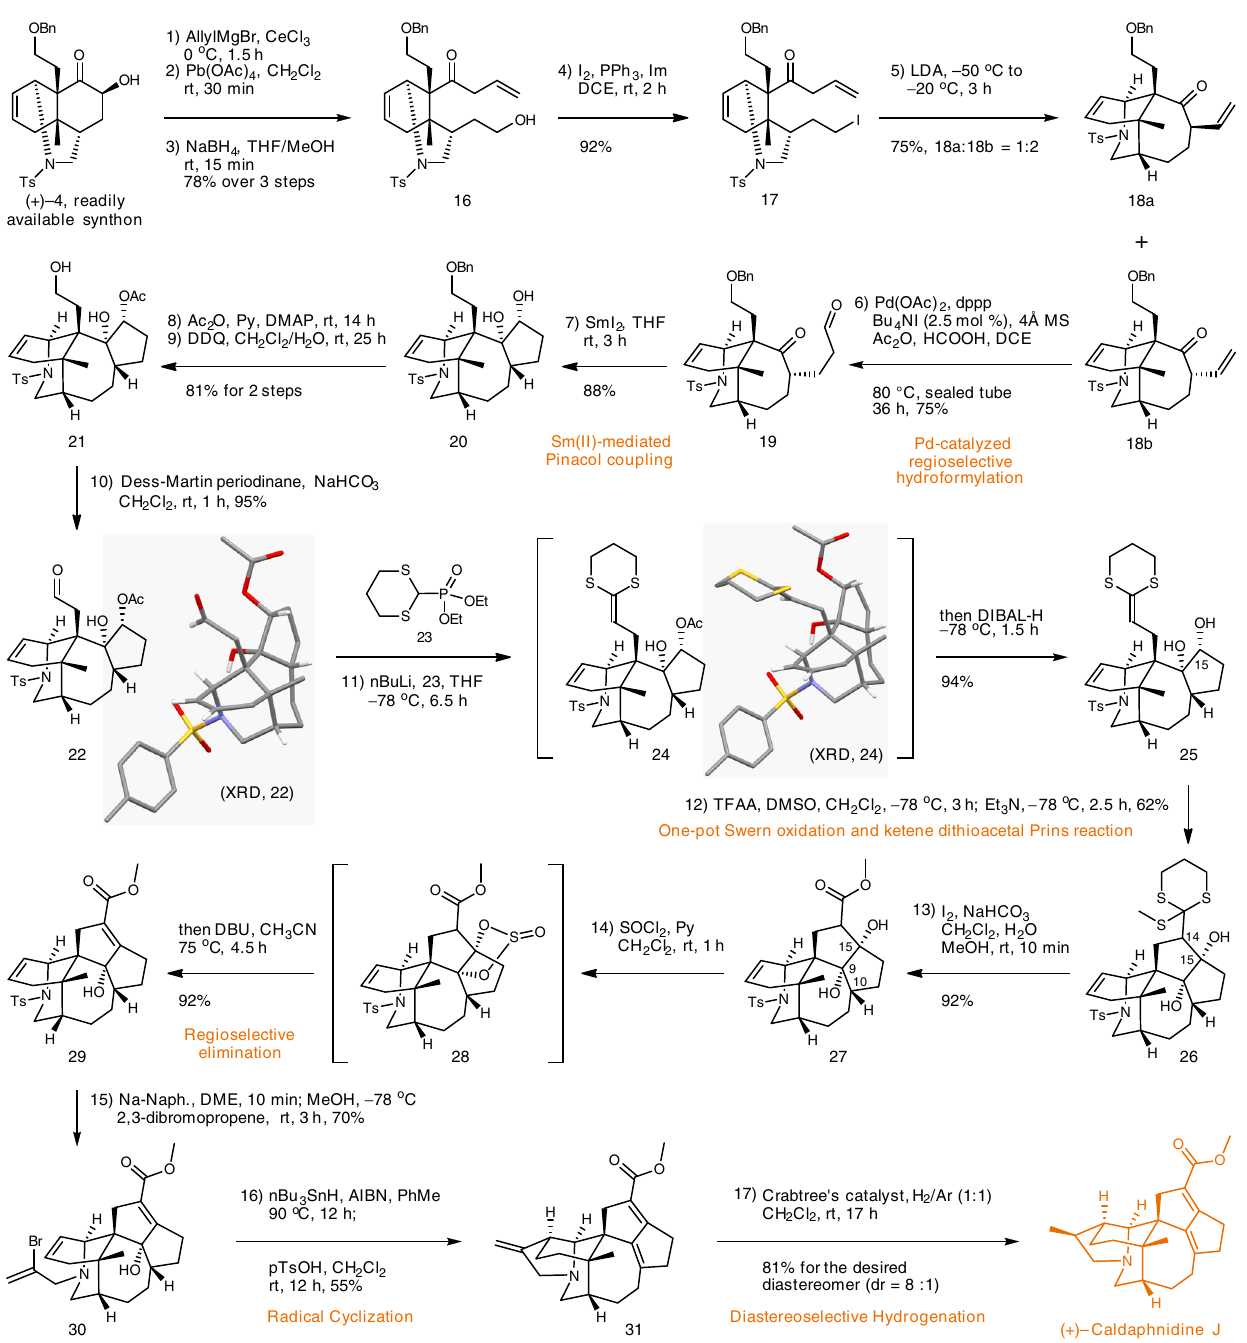
Fig. 4 Total synthesis of ( + )-caldaphnidine J. Key transformations were highlighted in colored text. Ac acetyl, AIBN azodiisobutyronitrile, DBU 1,8- diazabicyclo[5.4.0]undec-7-ene, DCE dichloroethane, DDQ 2,3-dichloro-5,6-dicyano-1,4-benzoquinone, DIBAL-H diisobutylaluminium hydride, DMAP 4- dimethylaminopyridine, DME 1,2-dimethoxyethane, dppp 1,3-bis(diphenylphosphino) propane, Naph. naphthalene, TFAA tri fl uoroacetic